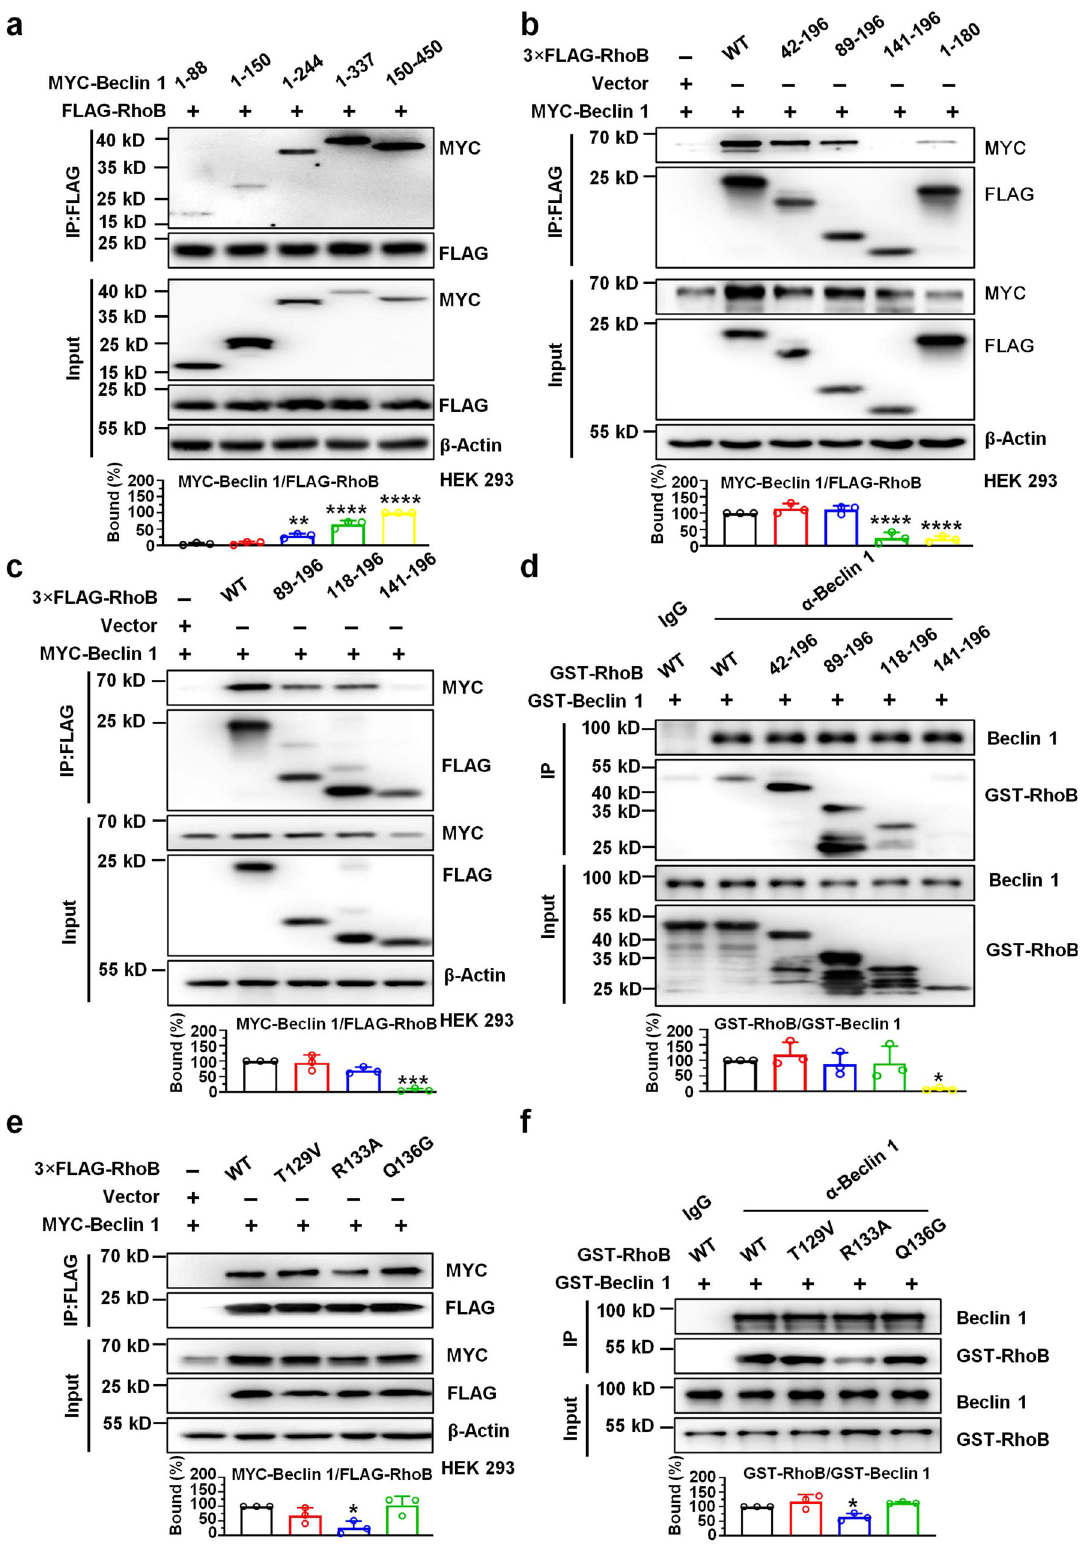
phagophore elongation), ATG7 (involved in phagophore elon- gation), ATG14 (involved in phagophore initiation) or Epg5 (involved in autophagosome-lysosome fusion) have no effect on bacterial load in urine at an early stage (24 h post infection), while ATG16L1 and ATG7 (but not Atg14 and Epg5) de fi cient mice harbor fewer UPEC QIRs (quiescent intracellular reservoirs)